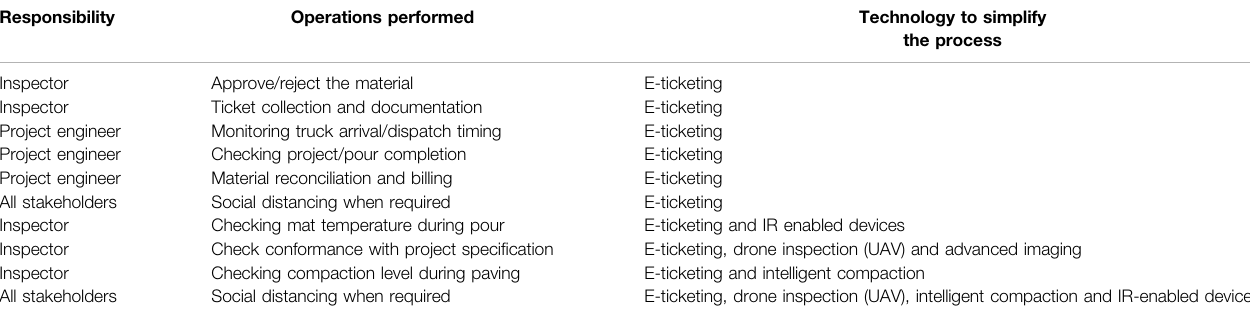
TABLE 8 | Technologies for automating/simplifying work